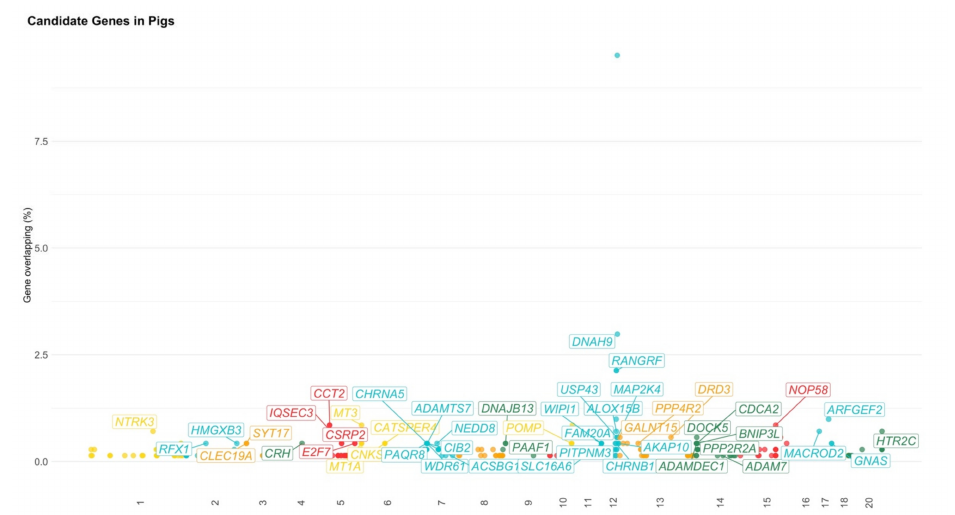
Figure 5. Manhattan plot of candidate genes in pigs. The x-axis represents the chromosomes; y-axis represents the gene overlapping in percentage (i.e., ratio of times of gene appearance and total number of genomic regions); the color represents the chromosomes; labelled boxes represent annotated genes with number of appearances higher than 3; chromosome 20 is the X (sex)